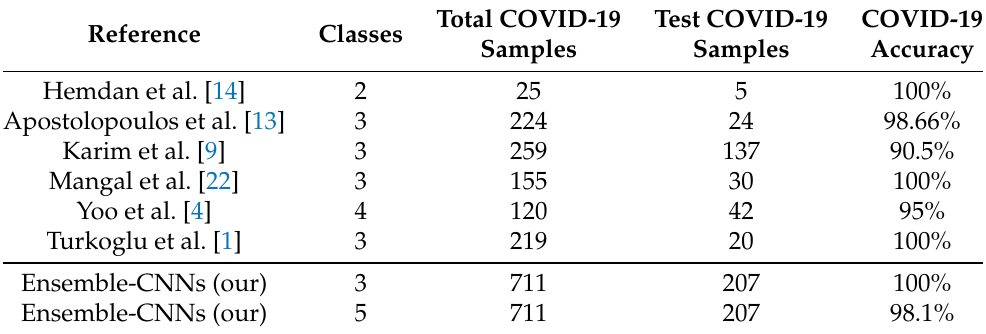
Table 13. Comparison between our results and the state-of-the-art results for the recognition of COVID-19 infection.